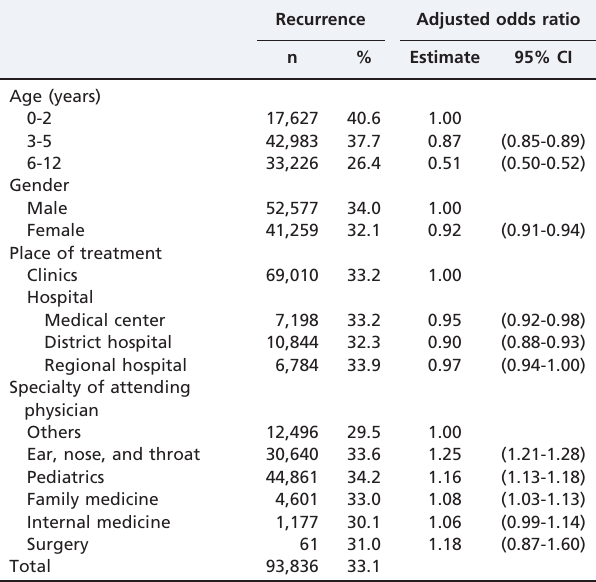
Table 3 - Predictors for recurrent episodes of acute otitis media (N = 283,084